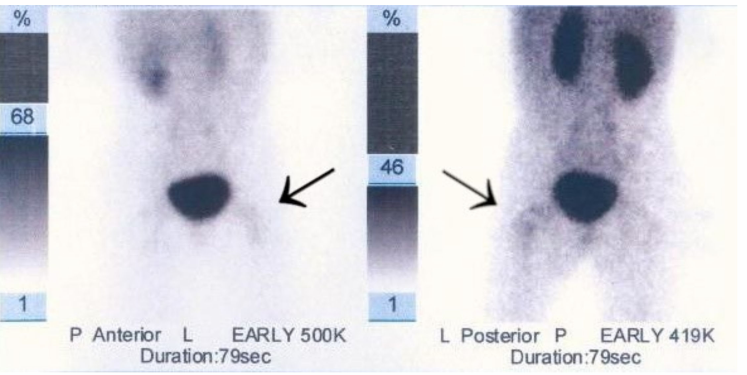
Figure 6. Scintigraphy scan of the patient. Arrows indicate increased radioisotope uptake in the left femoral